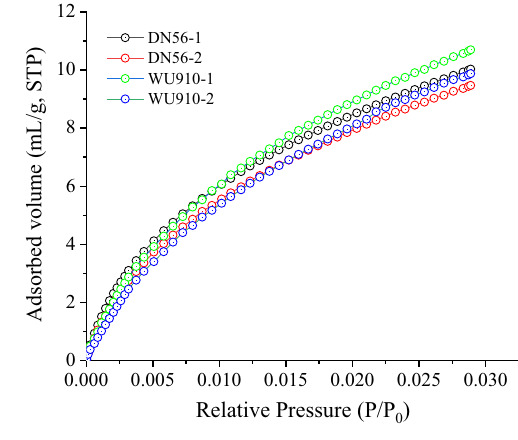
Fig. 5 CO 2 adsorption